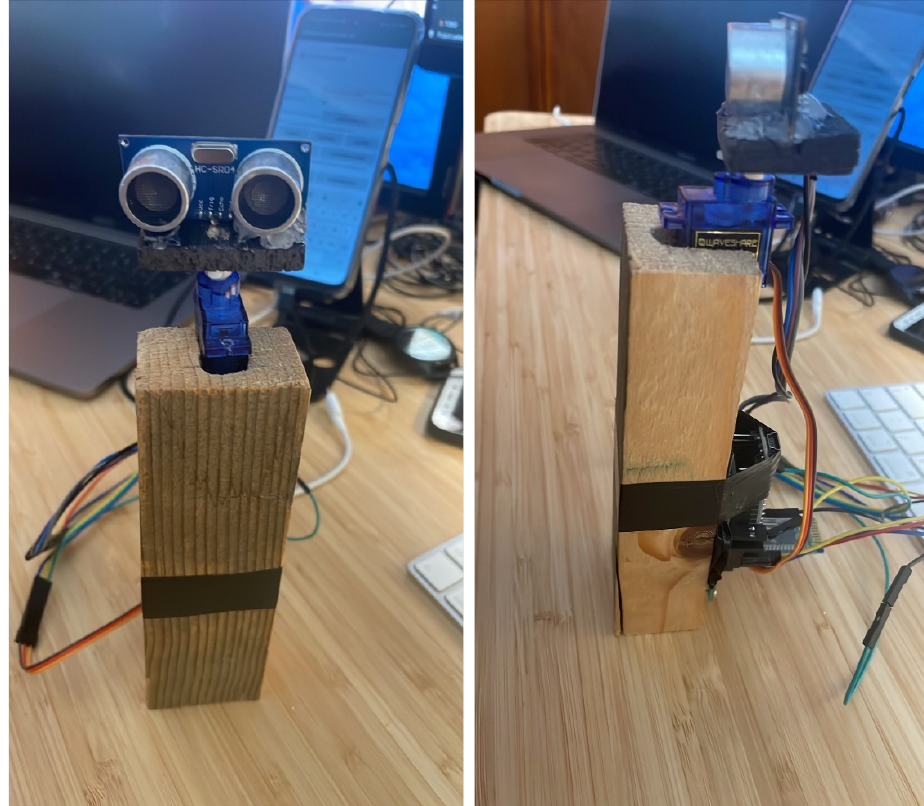
Figure 2. Prototype system for detailed obstacle detection.